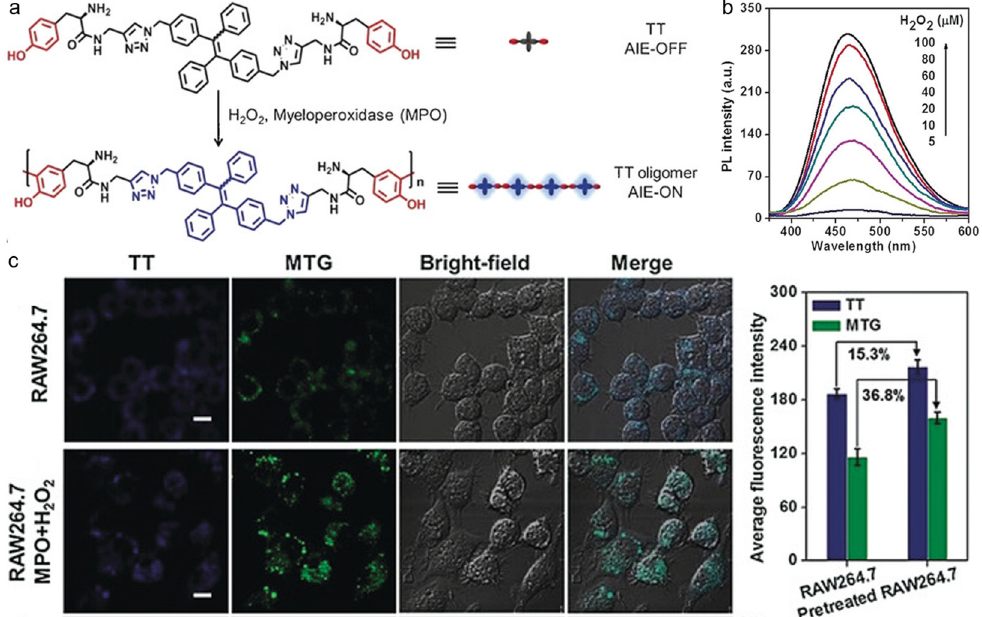
Figure 3. ( a ) Peroxidase-catalyzed polymerization in the presence of H 2 O 2 ; ( b ) PL spectra of TT with the treatment of different concentrations of H 2 O 2 ; ( c ) CLSM images and corresponding fluorescence intensity of RAW264.7 cells pretreated without and with MPO and H 2 O 2 incubating with TT. Scale bars: 20 µm. (Reproduced with the permission from ref. [113]. Copyright 2018, Wiley-VCH Verlag GmbH & Co. KgaA, Weinheim).